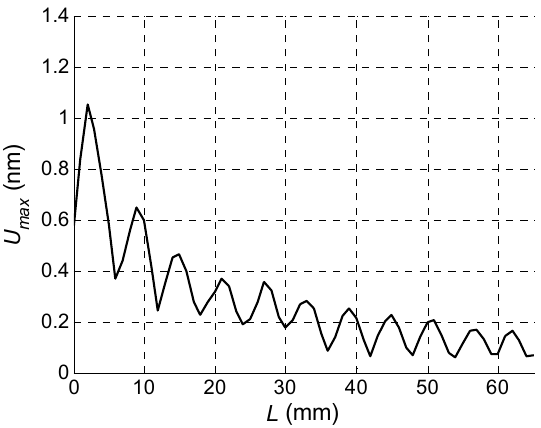
Figure 32. Spatial distribution of the peak values of the normal displacements U max of the PVC film when all array elements were excited simultaneously.